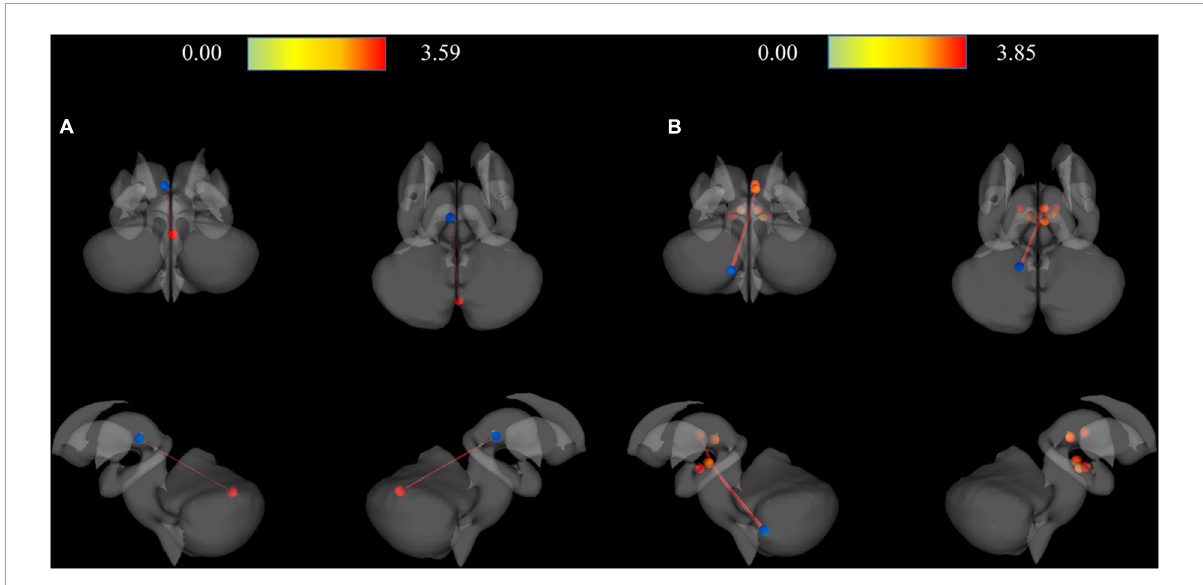
FIGURE3 3D rendering maps of ROI-to-ROI connection pairs in the subcortical regions. (A) Functional connection of L-Habe with Vermis_7 target presented on posterior, superior, left, and right views. Blue and red spots represent the L-Habe seed and the Vermis_7 target. (B) Functional connection of L-Cerevellum_9 seed with R-SN_pr, L-SN-pr, R-Thal_MDm, R-Red_N, L-Red_N, R-SN-pc, and R-Habe targets presented on posterior, superior, left and right views. Blue and red spots represent the L-Cerebellum_9 seed and seven targets, respectively. HC, Healthy controls; L-Cerebellum_9, Lobule IX of the left cerebellum; L-Habe, Left habenula; L-Red_N, Left red nucleus; L-SN_pr, Left substantia nigra, pars reticulata; MDD, Major depressive disorder; R-Habe, Right habenula; ROI, Region of interest; R-Red_N, Right red nucleus; R-SN_pc, Right